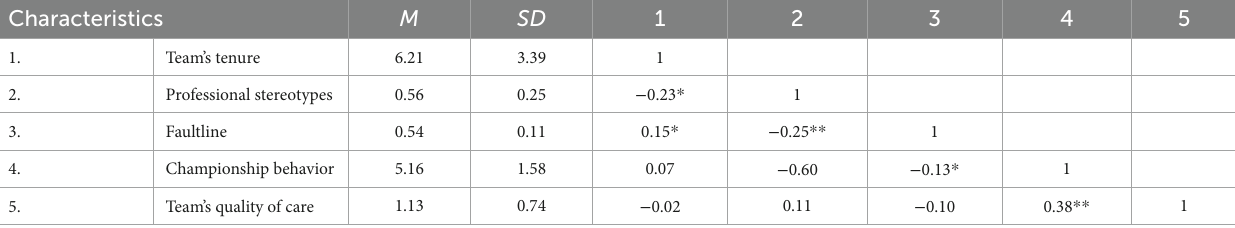
TABLE 1 Descriptive statistics and correlations between team’s quality of care and independent and control variables. Characteristics